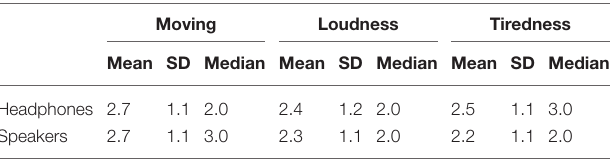
TABLE 3 | Mean, standard deviation, and median values for the answers to questions asked after each listening session: “Did you feel that you were moving?”; “Did you feel tired during standing?”; “Did you perceive the music as loud?” ( N = 35). Moving Loudness Tiredness Mean SD Median Mean SD Median Mean SD Median